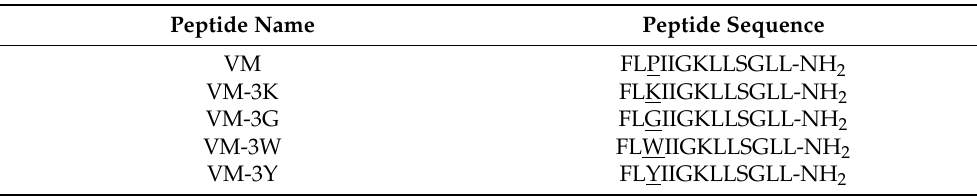
Table 1. The peptides synthesised and their sequences. The differences of the modified positions in analogues are indicated by